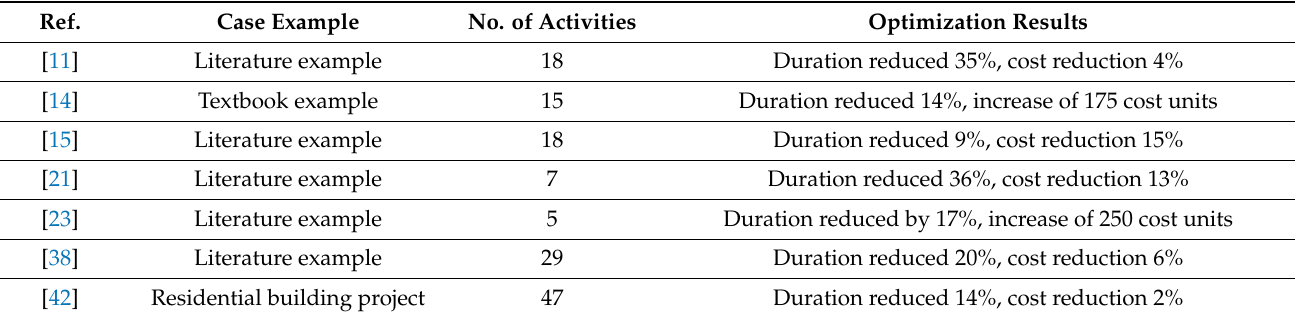
Table 3. Results of reviewed TCTP models.